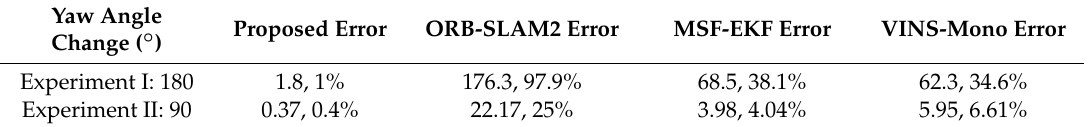
Table 4. Yaw angle accuracy ( ◦